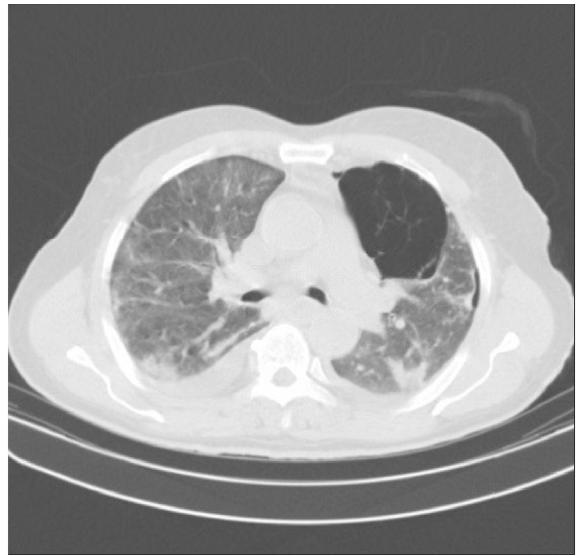
Figure 1: Chest CT showing patchy peripheral ground-glass opacities, and scattered subsegmental atelectatic bands are com- patible with COVID-19 pneumonia. A small amount of pneu- mothorax is seen in the right hemithorax particularly anteroinferiorly. Large emphysematous bulla is seen in the medial aspect of the left upper lobe, and a smaller similar bulla is seen in the right paracardiac region. Mild bilateral pleural effusion is also